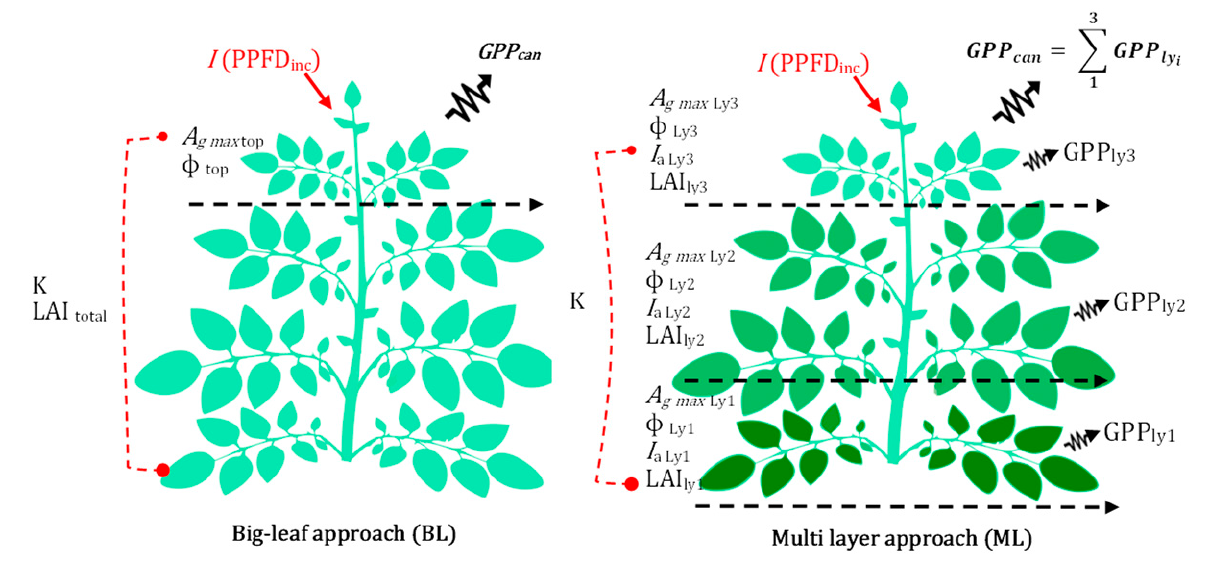
Figure 1. Schematic descriptions of the GPP can upscaling models Big-leaf (BL) and Multilayer (ML). Multilayer Approach (ML)